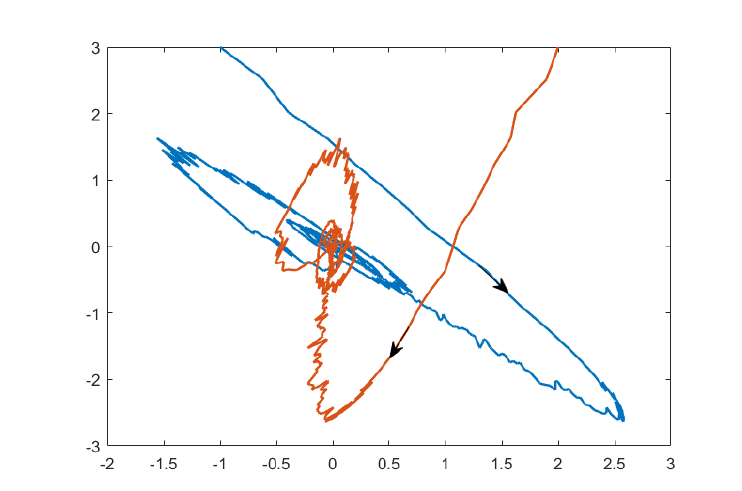
Figure 8. Phase plane of closed-loop systems with initial conditions ( − 2, 2).